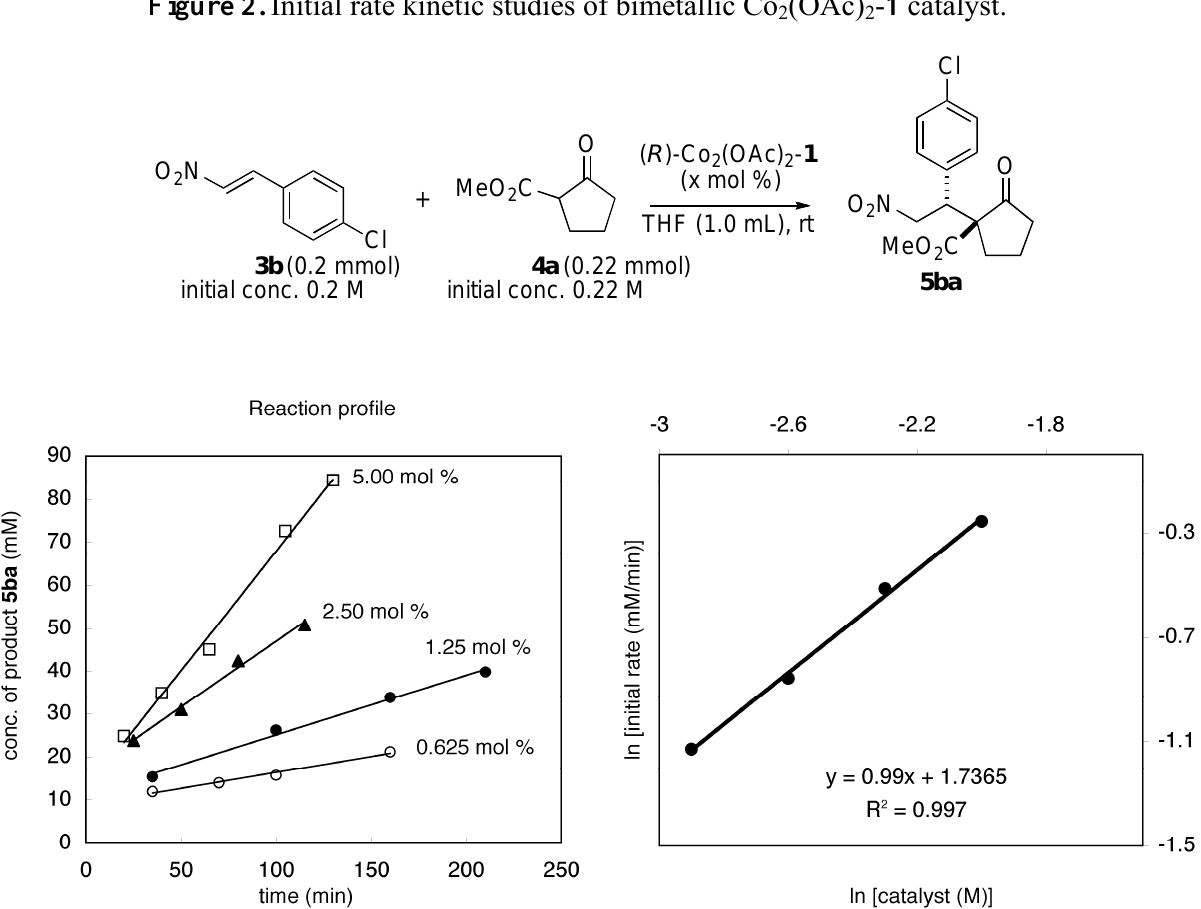
Figure 2. Initial rate kinetic studies of bimetallic Co